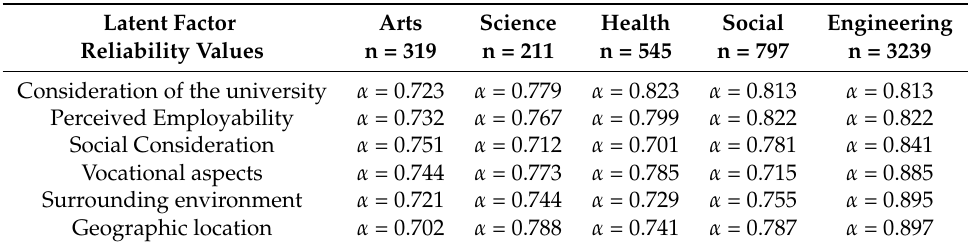
Table 2. Reliability values of the latent factors.